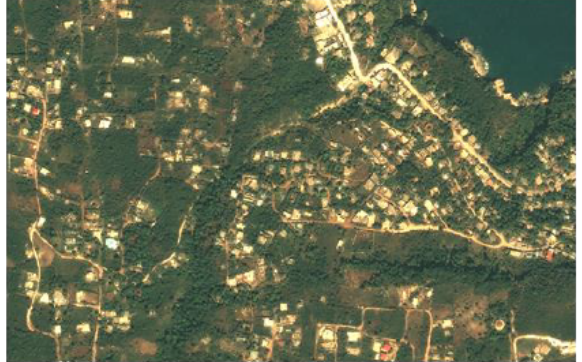
Figure 8. Haiti validation image